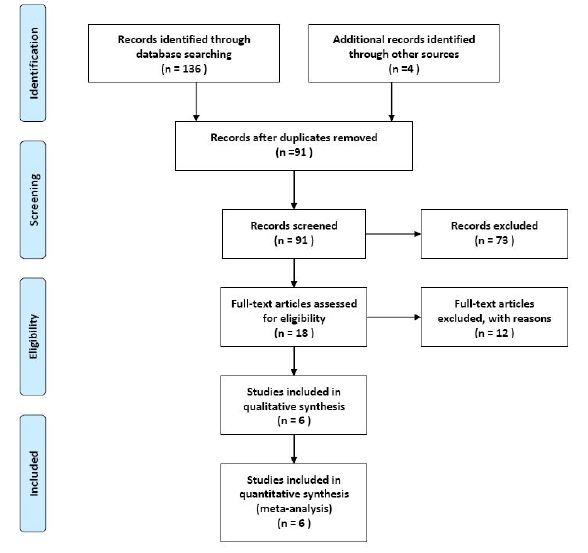
Figure 1: Publication searching